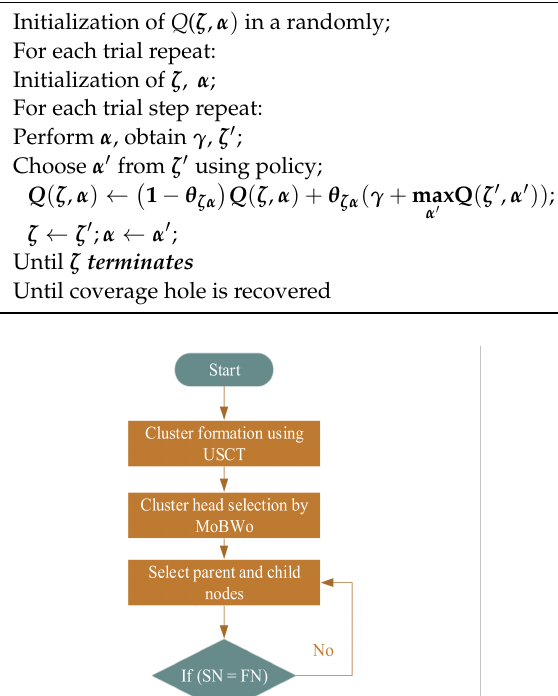
Algorithm 4 Coverage hole repair